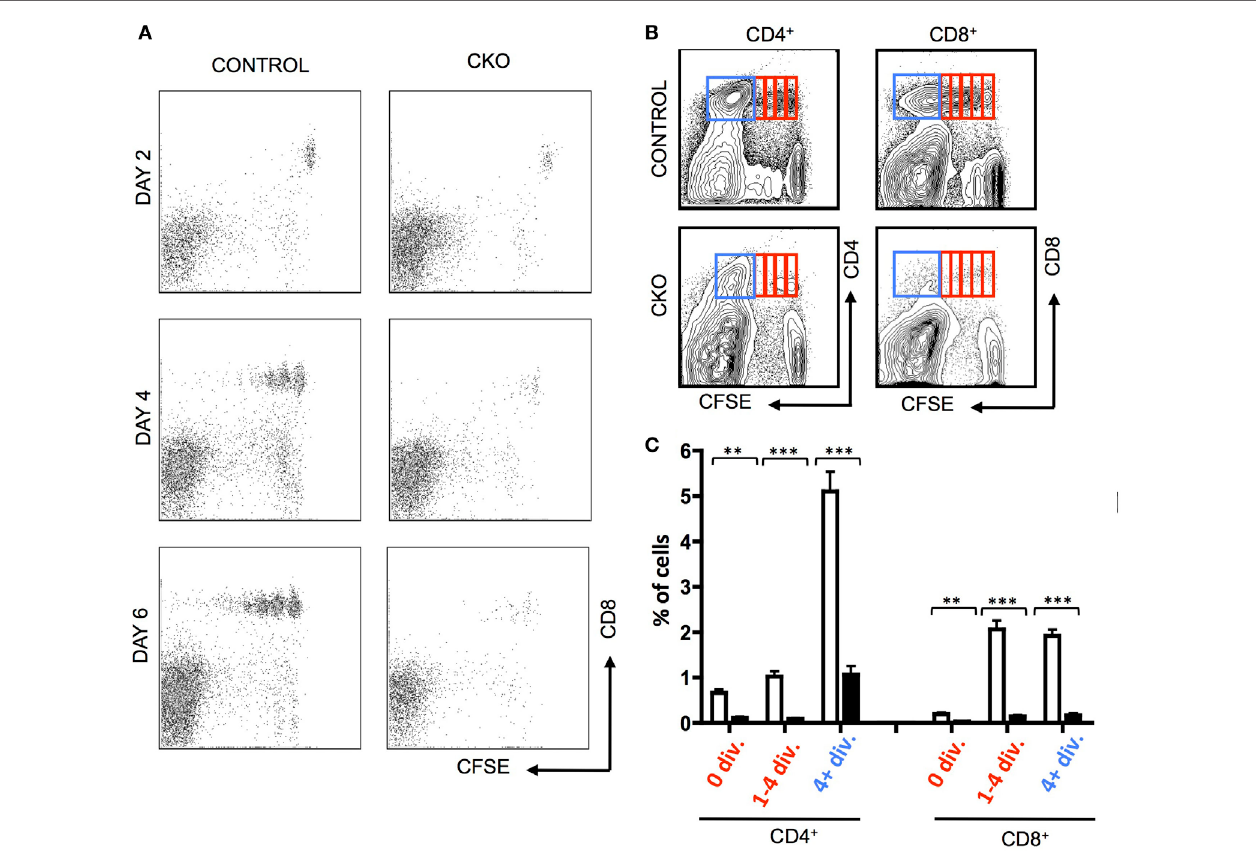
FigUre 2 | Zfx-deficient T cells fail to undergo acute homeostatic proliferation. (a) Expansion of T cells in a lymphopenic environment. Shown is FACS plots demonstrating carboxyfluorescein succinimidyl ester (CFSE) dilution in CD8 + control and conditional knockout T cells injected into RAG1 − / − mice and isolated from the lymph nodes at the indicated days. (B) Expansion of transferred T cells 7 days after transfer into RAG1 − / − mice. Shown is FACS plots demonstrating CFSE dilution in T cells within the lymph nodes 7 days after transfer. Data are representative of two independent experiments. (c) Quantification of T cell expansion 7 days after transfer into RAG1 − / − mice. Shown is the fraction of lymph node CD8 + cells that have divided 0, 1–4, or 4 + times in RAG1 − / − mice that received control ( n = 5) or CKO ( n = 3) splenocytes. Numbers represent percentage ± SEM. *** P < 0.001; ** P < 0.01; * P <